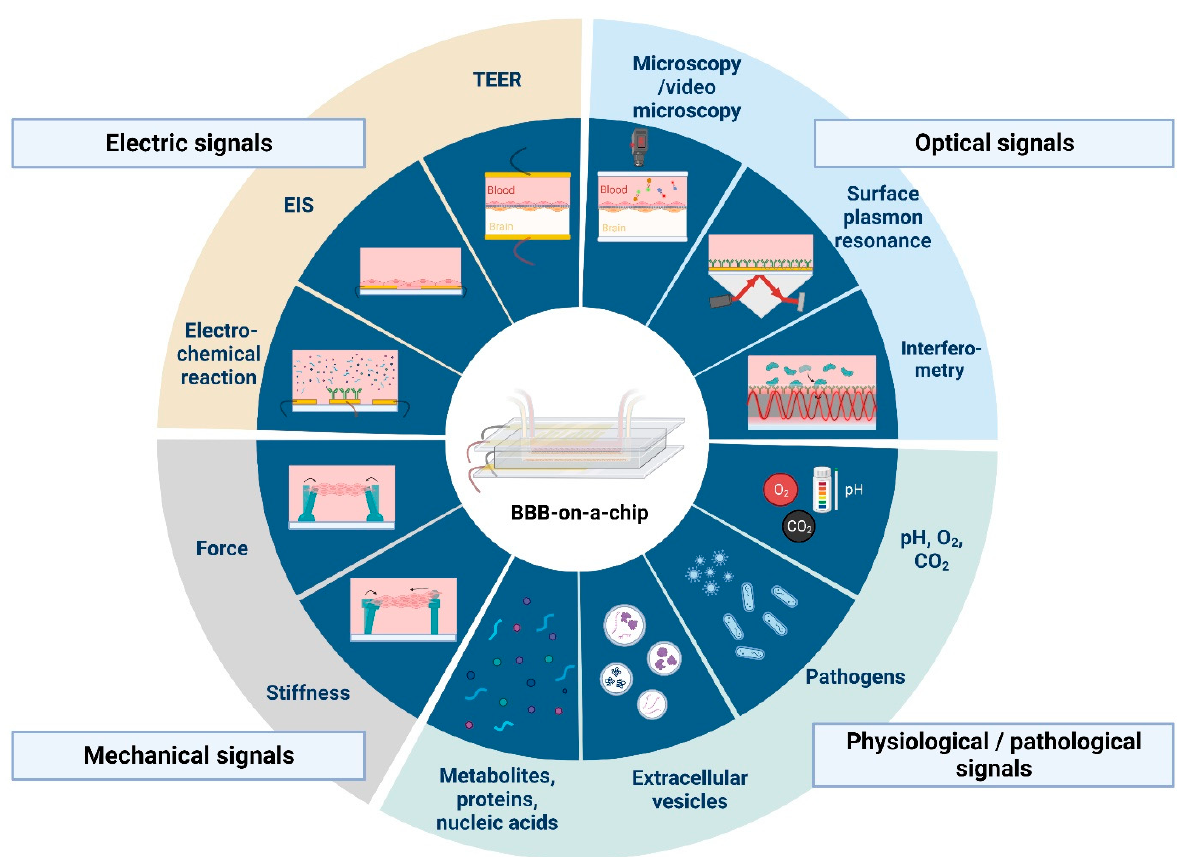
Figure 3. Current and potential sensing technologies that can be integrated with blood-brain barrier-on-a-chip devices. Abbreviations: TEER, transendothelial electrical resistance; EIS, electrical impedance spectroscopy. Created with BioRender.com.